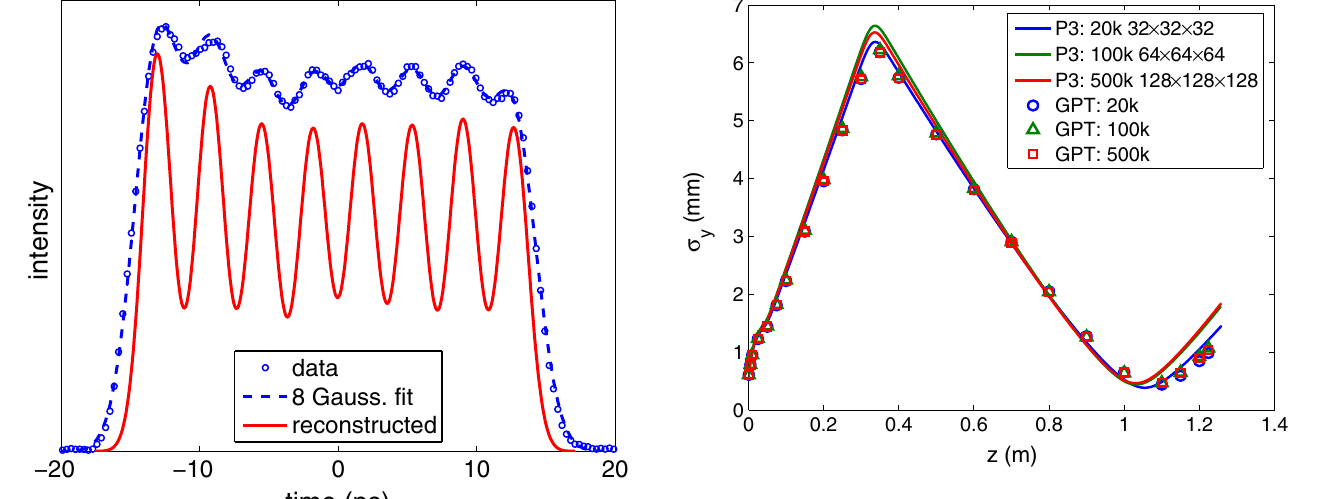
FIG. 8. (Color) Comparison of beam envelope vs longitudinal position calculations for PARMELA3D (solid lines) and GPT (open symbols) for 80 pC charge per bunch. The solenoid current is 3.6 A and the gun voltage is 250 kV. mesh sizes. The results are presented in Fig. 8 for the beam envelope and Fig. 9 for the emittance vs longitudinal position for the case of 80 pC bunches. Only the results for the vertical plane are shown. The horizontal beam size and rms normalized emittance (not shown) differ by maxi- mum 12% and 16% from their corresponding vertical values. An additional difference between PARMELA3D and GPT is that the former reports the relevant beam parameters as a function of time, while for the latter we have used the 3D coordinates of the bunch projected to a given longitu- dinal position. We observe that sufficient convergence is demonstrated with 100k macroparticles for both